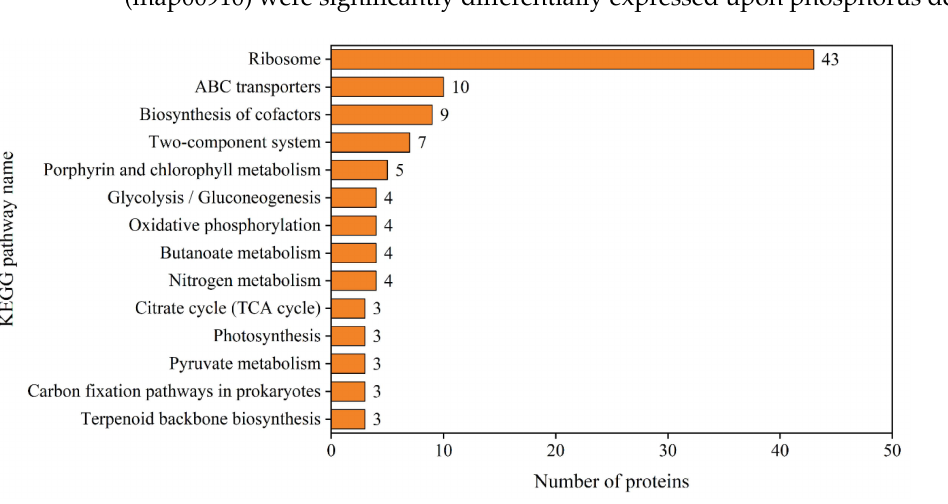
Figure 4. KEGG pathways with at least three differentially abundant proteins in Microcystis aeruginosa FACHB-905 upon phosphorus depletion. Y-axis represents KEGG pathway. X-axis numbers represent the number of differentially abundant proteins involved in each KEGG pathway, and the number is also shown next to the